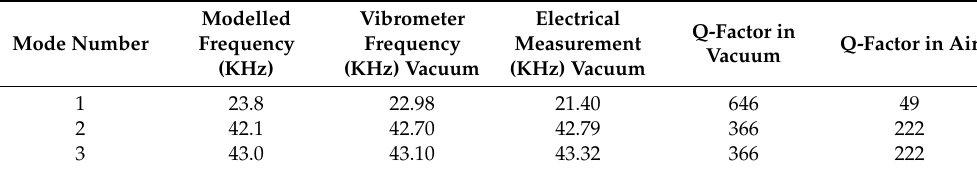
Table 4. First three modes (modes of